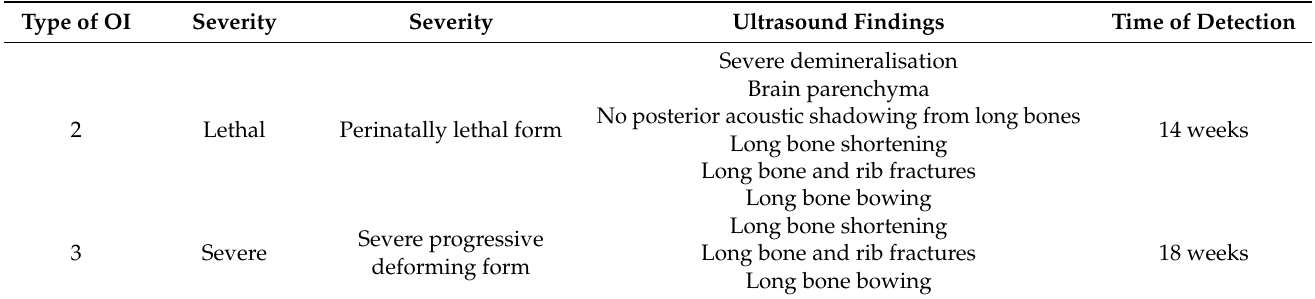
Table 2. Typical ultrasound findings of severe